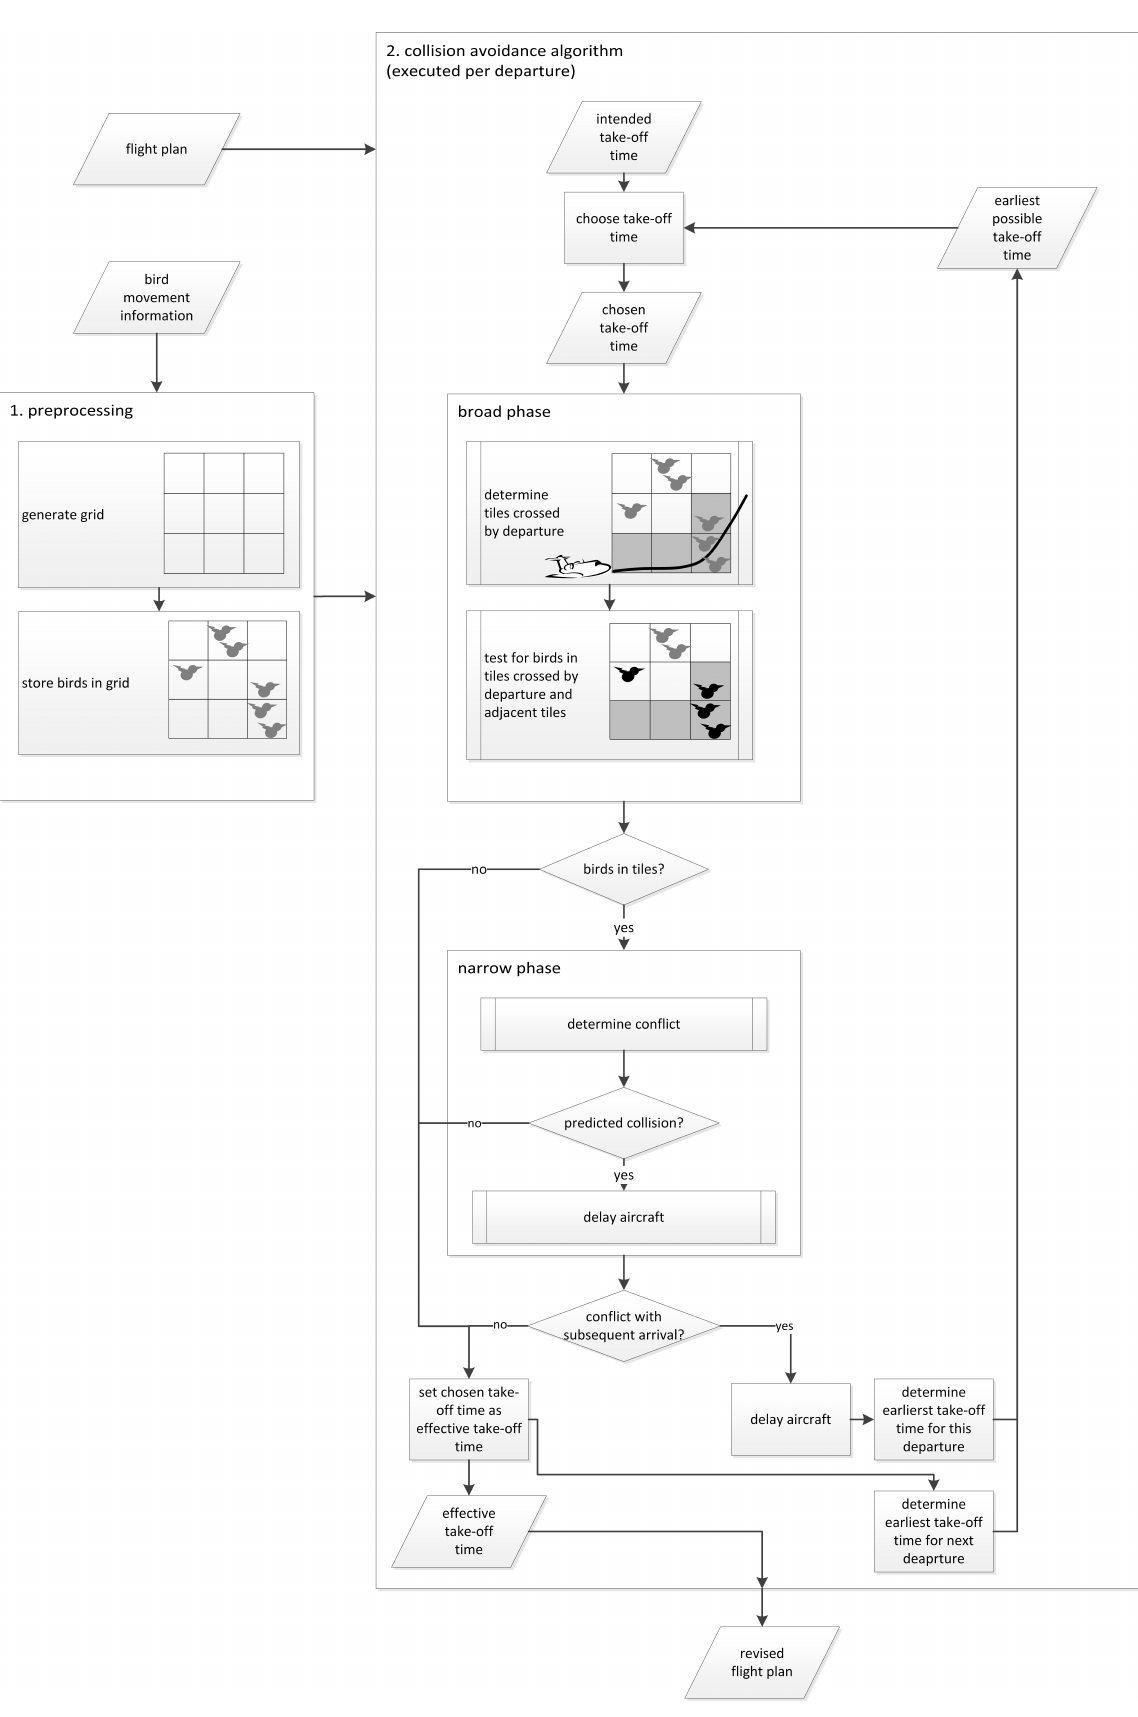
Figure 1. Set-up of the collision avoidance